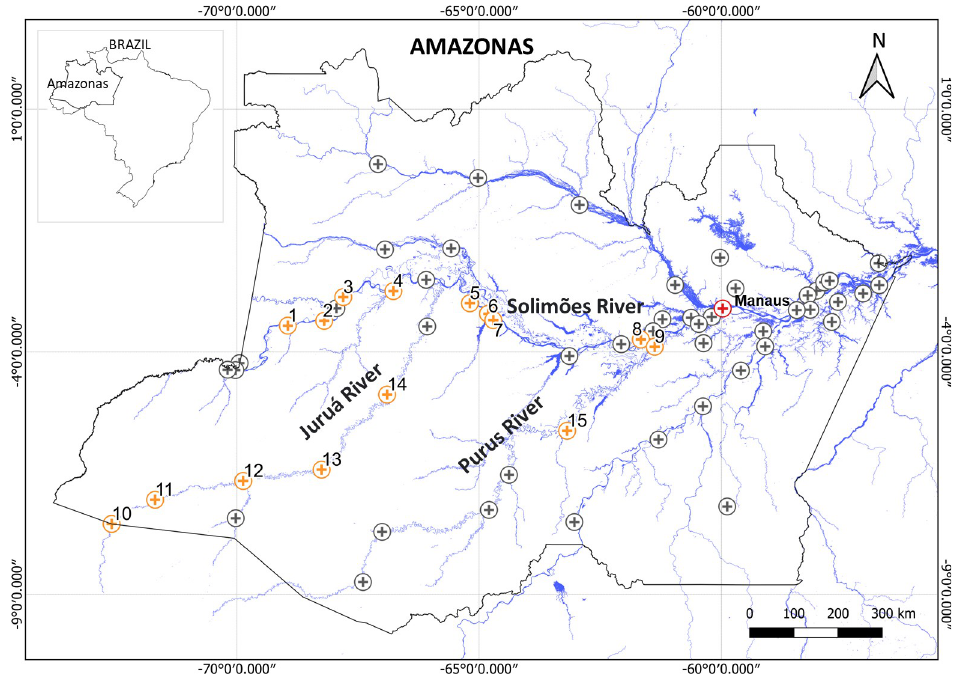
Fig 1. Location of the state of Amazonas, Wester Brazilian Amazon. Circles represent urban areas of 61 municipalities that have snake antivenoms available. Yellow circles represent municipalities with at least one riverine community included in this study. A total of 141 communities in 15 municipalities were visited: along the Solim õ es River (Alvar ã es, Amatura´, Anori, Jutaı´, S ã o Paulo de Olivenc¸a, Tefe´, Tonantins, and Uarini), the Jurua´ River (Carauari, Eirunepe´, Guajara´, Ipixuna, and Itamarati), and the Purus River (Anori, Beruri, and Tapaua´). 1-S ã o Paulo de Olivenc¸a; 2-Amatura´; 3-Tonantins; 4-Jutaı´; 5-Uarini; 6-Alvar ã es; 7-Tefe´; 8-Anori; 9-Beruri; 10-Guajara´; 11-Ipixuna; 12-Eirunepe´; 13-Itamarati; 14-Carauari; 15-Tapaua´. Manaus (red circle) is the state capital and has the referral center for treating severe snakebite cases at the Fundac¸ ã o de Medicina Tropical Dr. Heitor Vieira Dourado. Base used